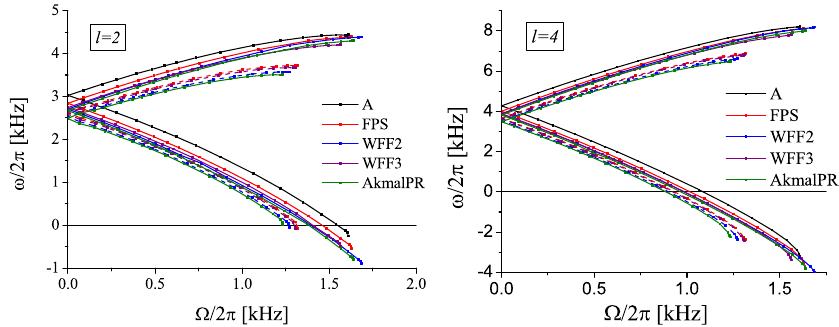
Fig. 13 f -mode frequencies in the inertial frame as a function of the stellar rotation angular frequency for different EOSs labeled as A, FPS, WFF2, WFF3 and AkmalPR (see Doneva et al. 2013a for more details). Left: l = | m | = 2. Right: l = | m | = 4. (Image reproduced with permission from Doneva et al.